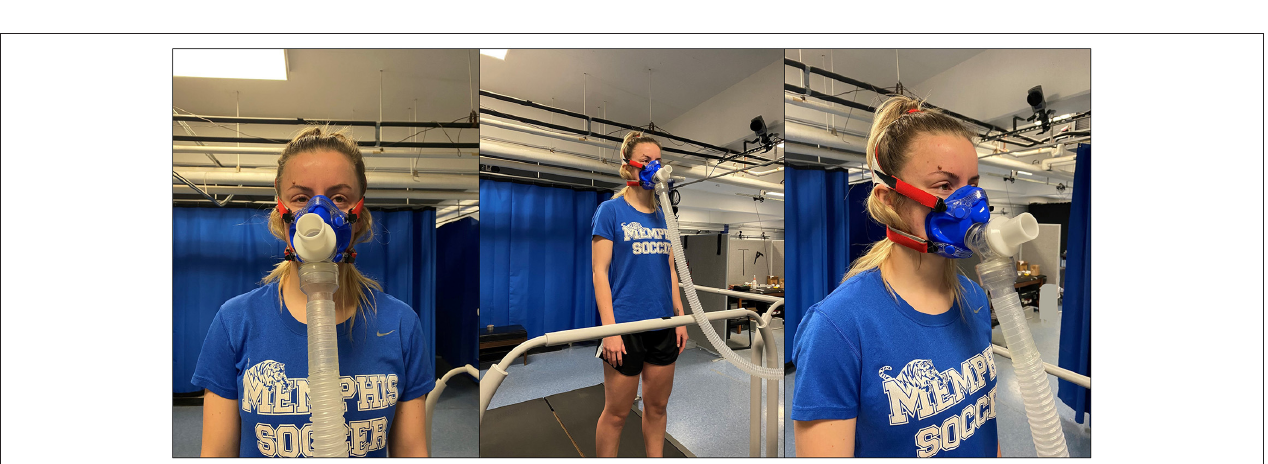
FIGURE 2 | Anterior and anterolateral views of the ParvoMedics TrueOne metabolic measurement system. Expired gases were collected from the participant via a face mask and plastic hose. A proper seal around the mouth and nose was confirmed by research staff prior to testing.